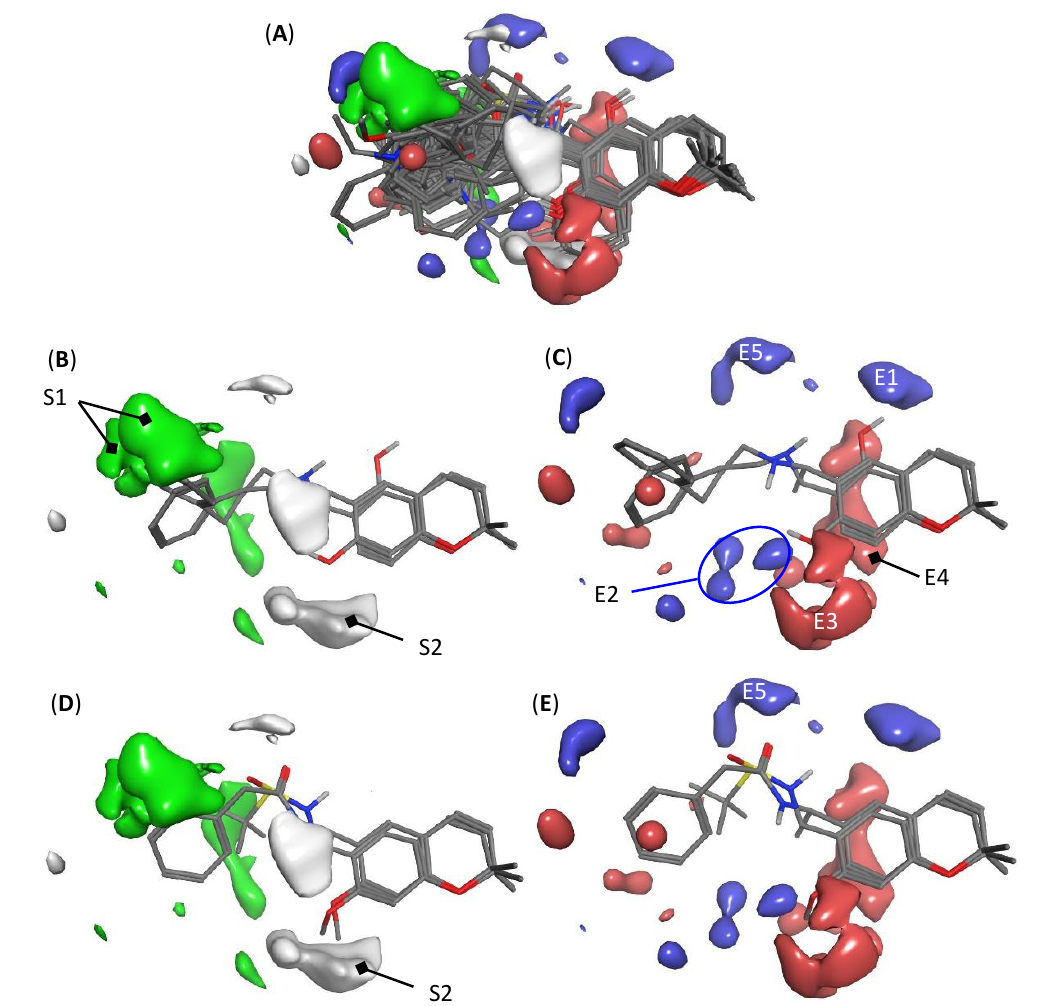
Figure 3. Comparison of MIF regions of the 3D-QSAR model K with strong impact on antiplasmodial activity. In the structures, only polar hydrogens are shown. Steric interactions are shown in green and white, indicating positive and negative impact of steric bulk/Van der Waals interactions on activity, respectively. Electrostatic interactions are shown in blue and red. Blue indicates regions where interaction of positive partial charge (electron deficient partial structure) on the ligand has a positive impact, red indicates regions where interaction of a negative partial charge (electron rich structure element) on the ligand has a positive impact on activity, and vice versa for detrimental effects. ( A ) Superposition of all compounds; ( B , C ) superposition of the most active congeners, 1 and 2 (pIC 50 = 8.0 in both cases); ( D , E ) compounds with very low activity, 49 and 52 (pIC 50 = 4.9 and 4.5, respectively).